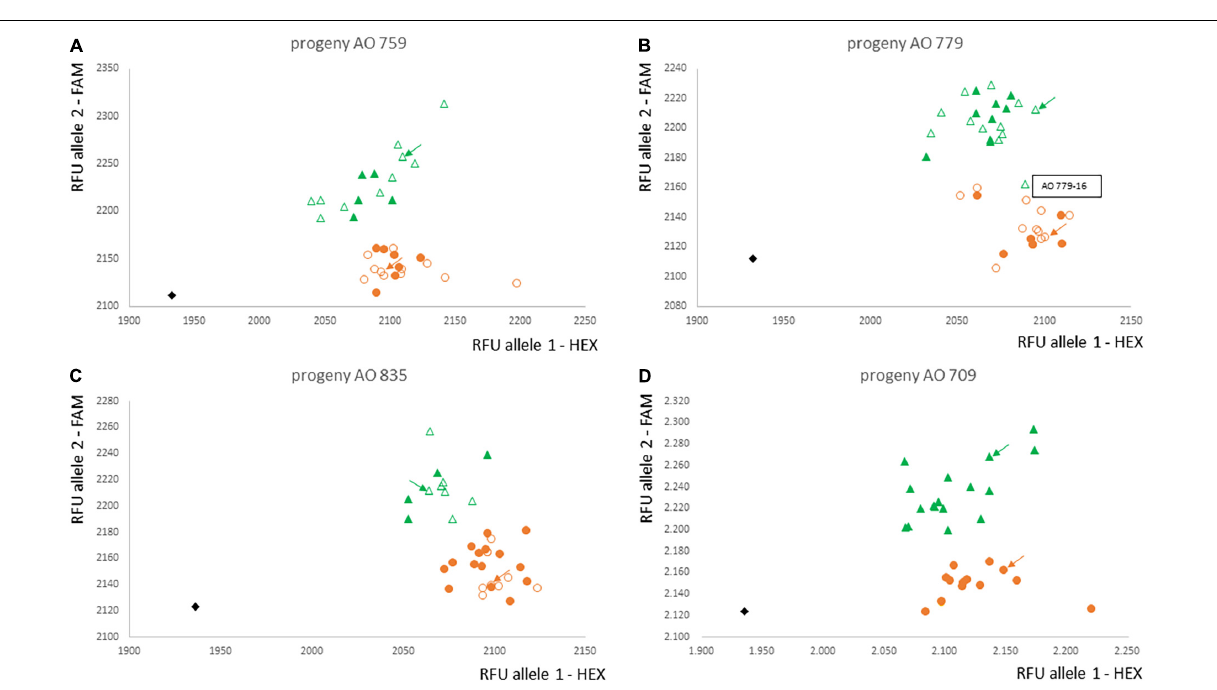
FIGURE 4 | Validation of marker KASP-Ax-553065352 for the complete progenies AO 759 (A) , AO 779 (B) , AO 835 (C) , and the progeny AO 709 not used for the array (D) . Orange circles: homozygous A. officinalis marker allele; green triangle: heterozygous; black rhomb: water control; unfilled symbols: already analysed with array; filled symbols: newly analysed plants; plant AO 779-16: homozygous marker type but AV-1-resistant phenotype; green and orange arrows: parental plants; RFU, relative fluorescence units; HEX and FAM: used fluorescence